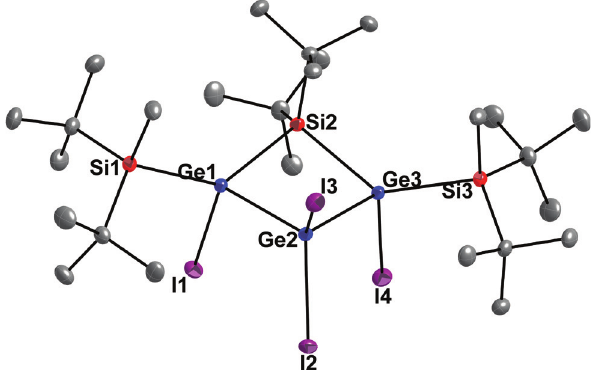
Figure 1 Crystal structure of the tetraiodido-substituted derivative 2 . ORTEP plot with thermal ellipsoids drawn at the 50% probability level; hydrogen atoms are not shown. Selected bond